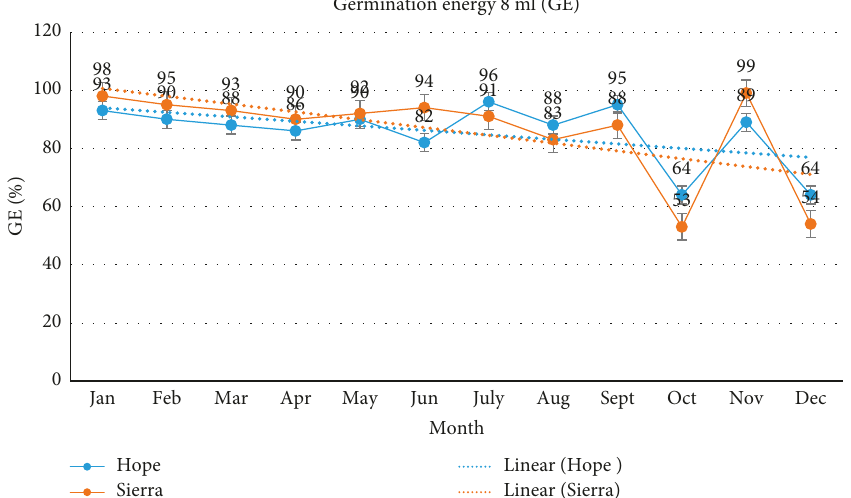
Figure 3: Comparison of germination energy (8ml) for Hope and Sierra malting barley varieties over the 12-month storage